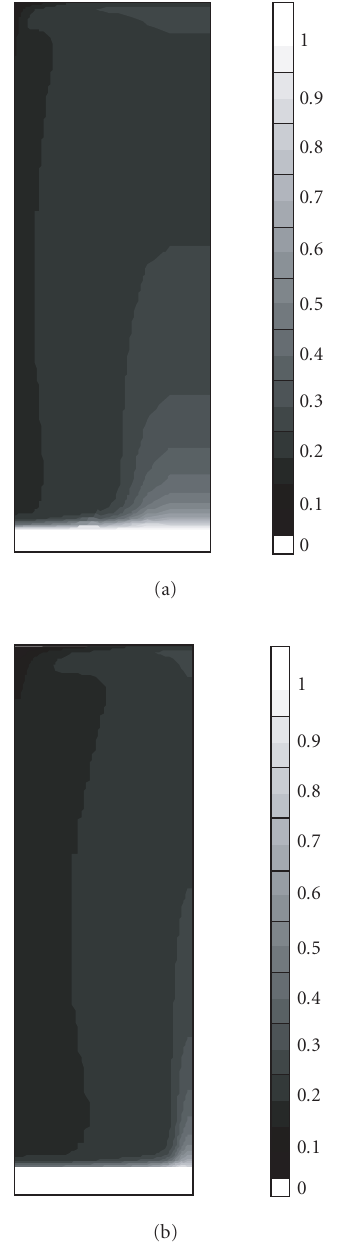
Figure 5: Thermal field on meridional plane in drum under spin- down process from 5 s/rev to zero: (a) t = 6 seconds and (b) t = 40